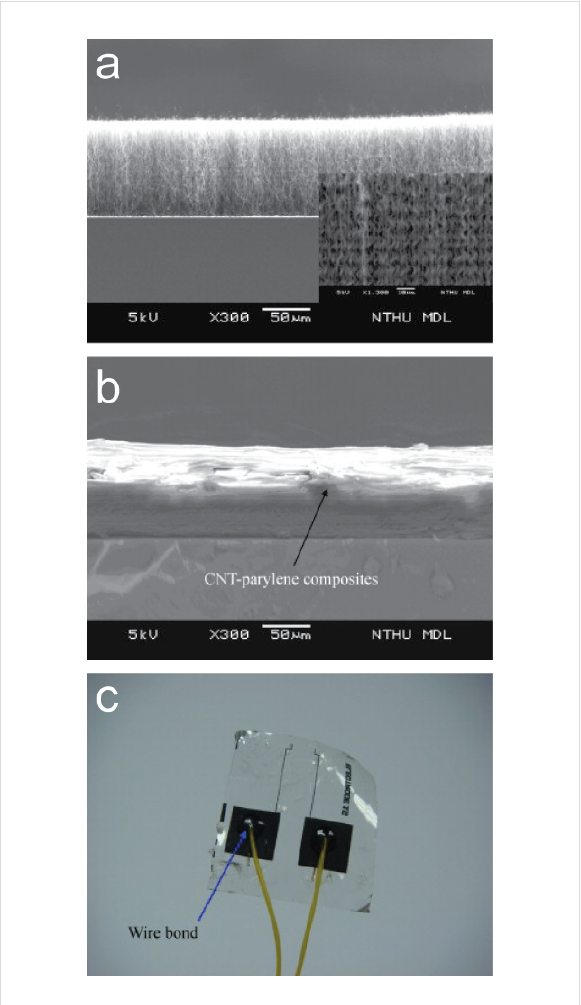
Figure 1: Flexible MEA developed by Lin and colleagues. SEM micro- graphs showing vertically aligned CNTs on Parylene-C (a,b) and a photo of the transparent flexible CNTs electrodes (c). Reproduced and modified from [116] with permission. Copyright 2009 Elsevier.